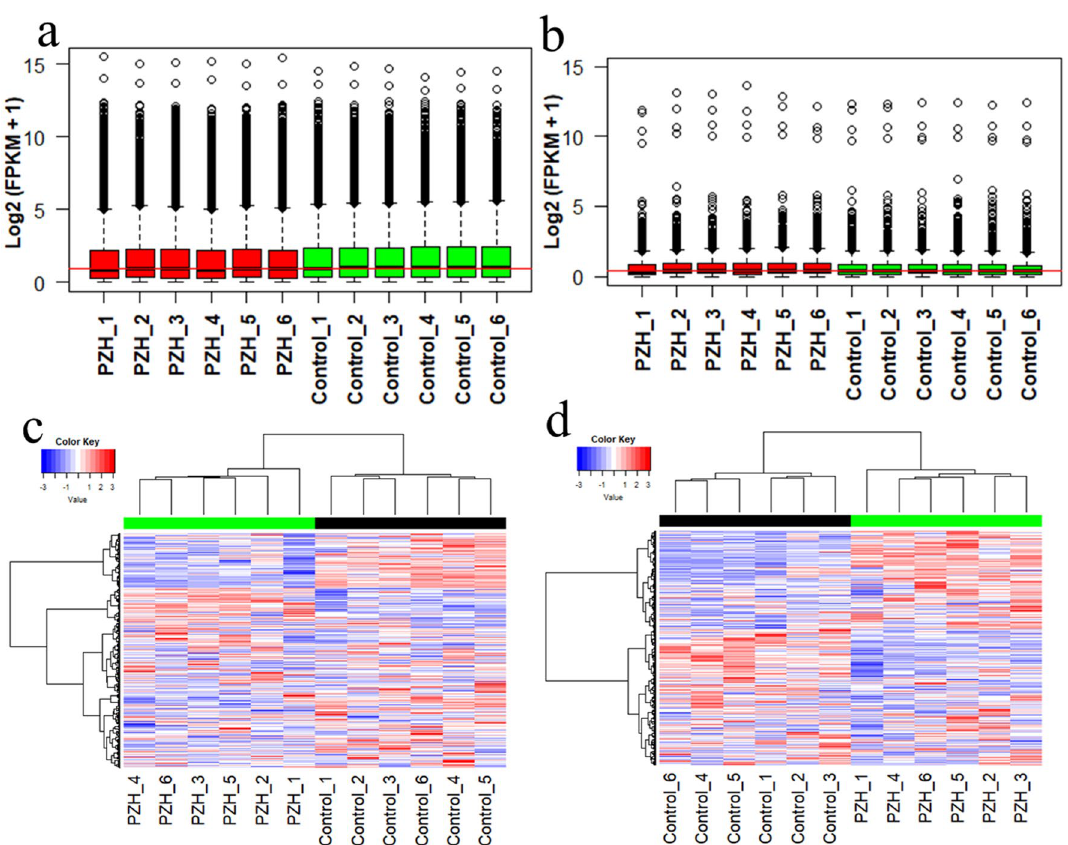
Figure 3. Visualization of the overall expression levels across all the samples at the time point of eighth week. ( a ) Expression levels of protein-coding transcripts and ( b ) expression levels of lncRNA transcripts; the x-axis indicates the names of the 12 samples, and the y-axis indicates the log 2 (FPKM + 1) value. ( c ) Hierarchical clustering result of the protein-coding transcripts. ( d ) Hierarchical cluster result of lncRNA transcripts. The mean was set to 0, and the standard deviation was set to 1 in the calculation of the log 2 (FPKM + 1) value of each gene in the 12 samples. Red indicates a high expression level, while blue represents a low expression level. Heat maps of ( c ) and ( d ) were created using R programming language (R: A Language and Environment for Statistical Computing, R Core Team, R Foundation for Statistical Computing, Vienna, Austria, 2016, https:// www.R- proje ct.